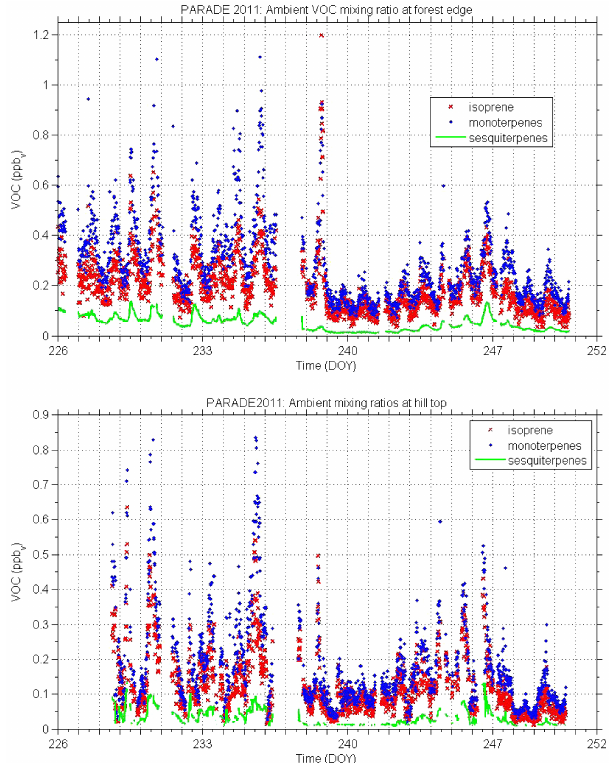
Figure 6. Measured volume mixing ratios at the forest edge (top) and calculated mixing ratios at the hill top (bottom) of isoprene, mono- and